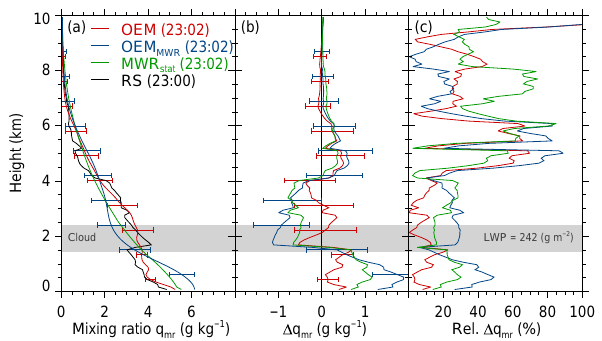
Figure 12. As Fig. 9 but on 21 April 2013 around 23:00UTC. The grey area indicates the cloud with an LWP of 242gm − 2 .